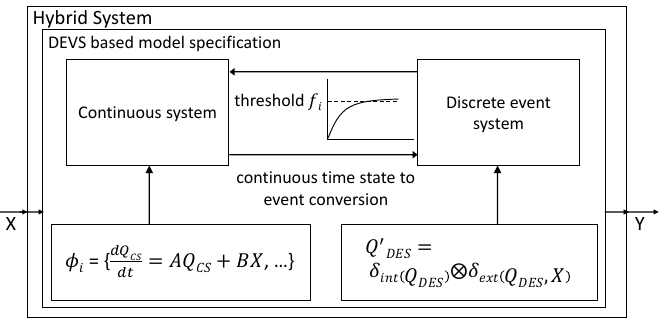
Figure 2. Specification of a hybrid